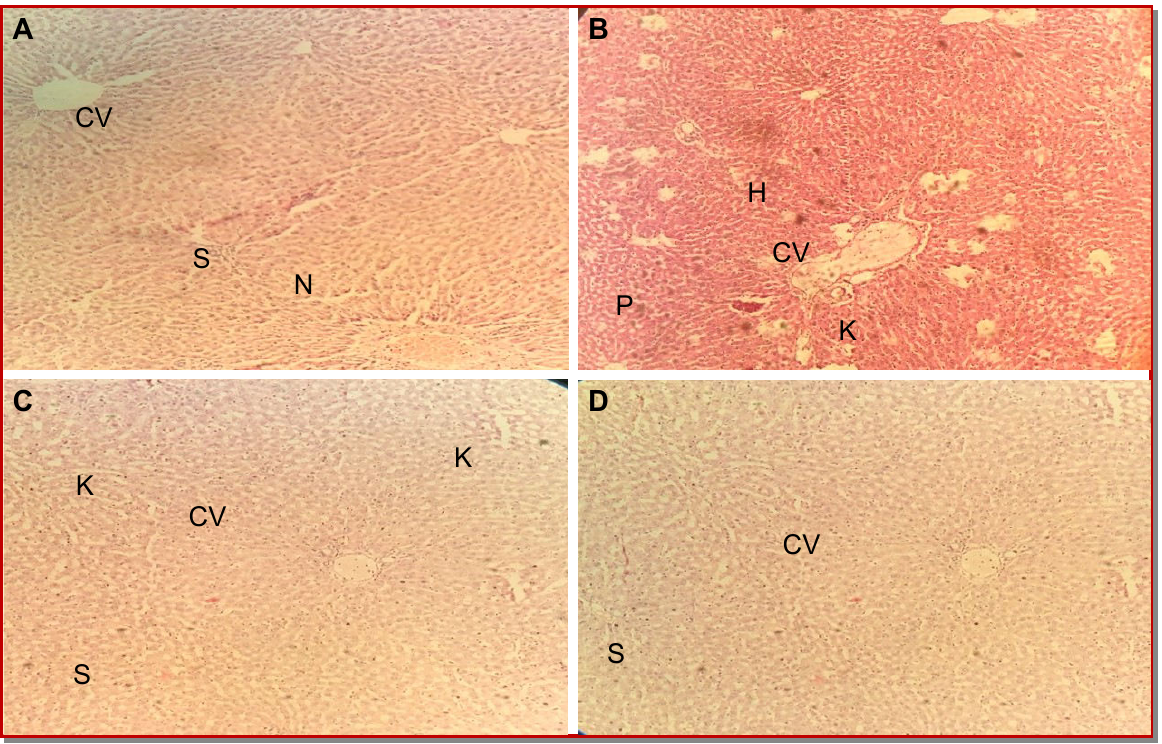
Figure 2: Liver section stained hematoxylin and eosin. A: Normal control group showing central vein (CV), hepatocyte with prom- inent nuclei (N) and hepatic sinusoids (S); B: Paracetamol group showing inflammatory cells infiltrating around central vein (CV), hepatocellular necrosis with hemorrhage between hepatocytes (H); C:silymarin group showing that hepatocyte (H) mostly had normal appearance less dilated blood sinusoids and activated Kupffer cells (K); D: ethyl acetate extract group showing restored hepatocytes architecture, with less dilated blood sinusoids (S) with activated Kupffer cells